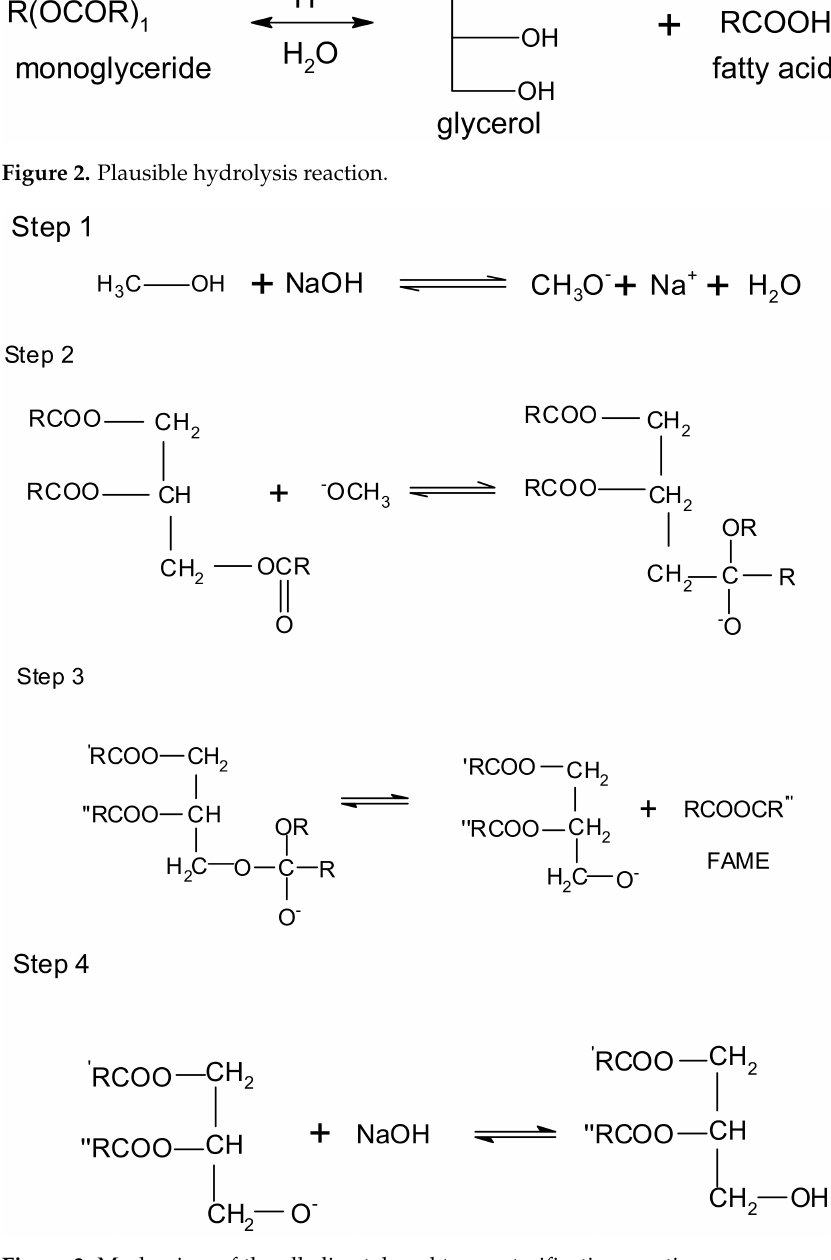
Figure 3. Mechanism of the alkali-catalyzed transesterification